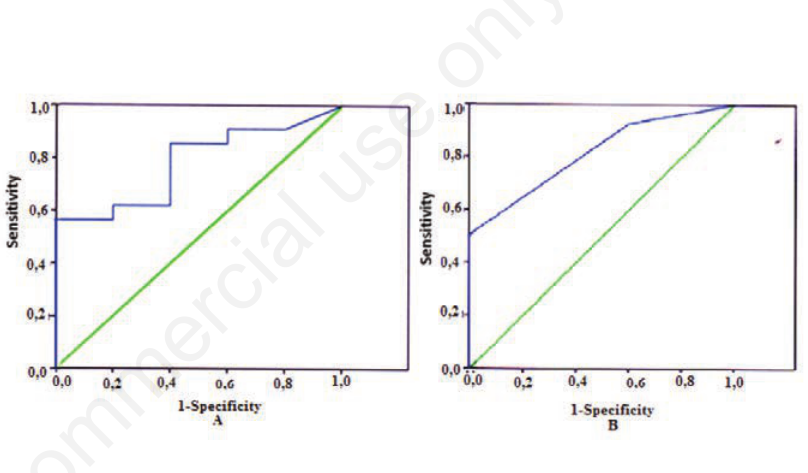
Figure 1. Diagnostic of echocardiography of AUC value (A) NT-ProBNP and (B) Hs- Troponin I. The ROC Curve is a graphical method of assessing the characteristic of a diagnostic